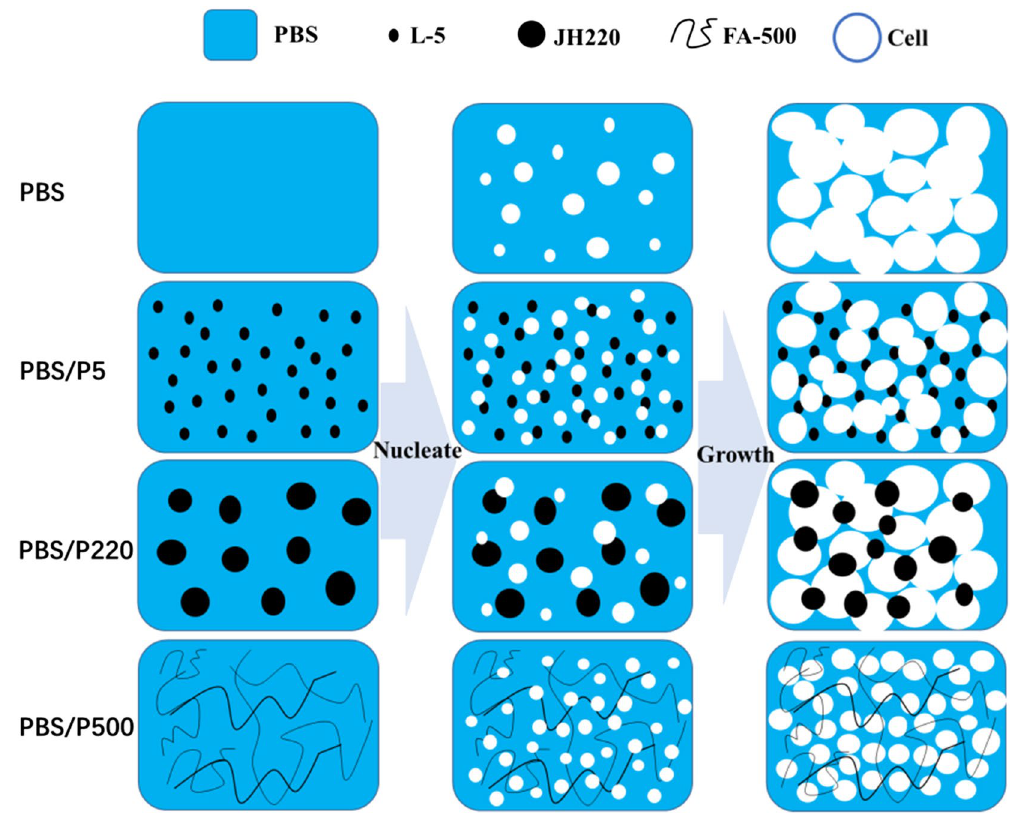
Figure 12. Schematic illustration of fabricating PBS and PBS/PTFE composite foams via scCO 2 batch foaming.